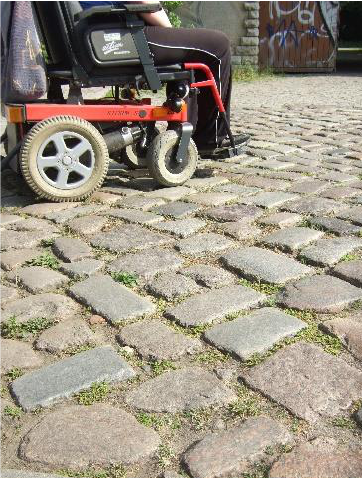
Figure 1. Cobblestones.